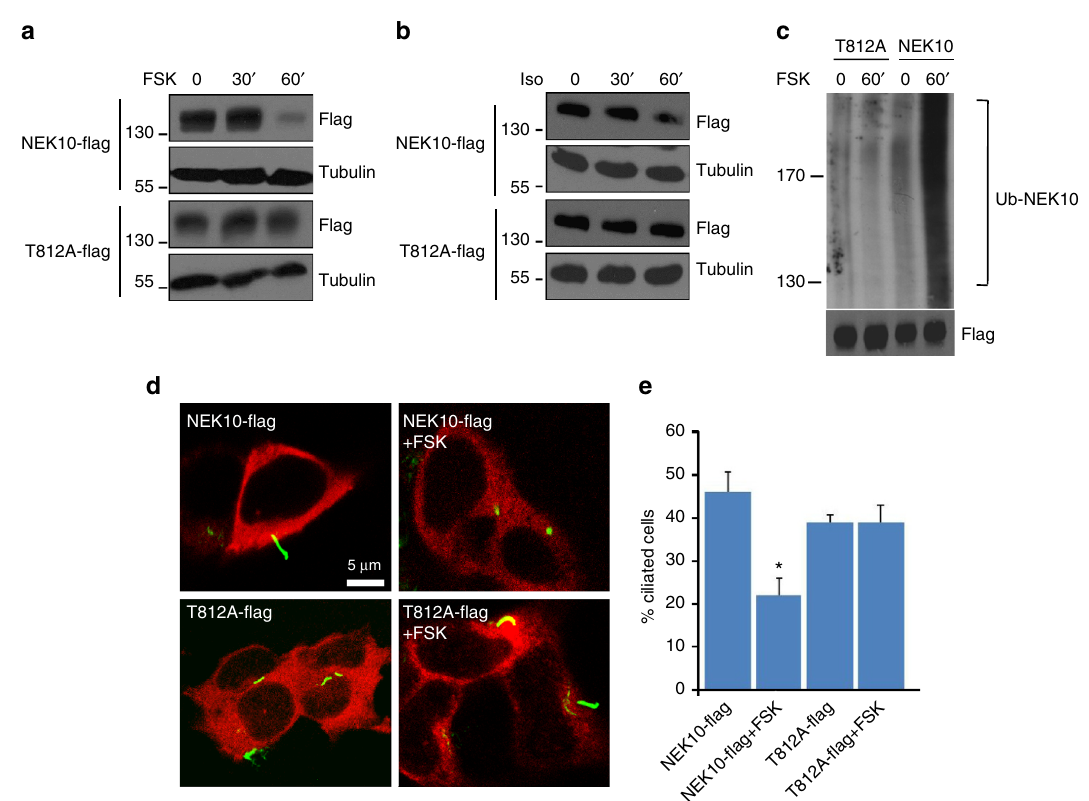
Fig. 4 PKA phosphorylation induces NEK10 proteolysis and cilia resorption. a – b Cells transfected with either wild-type NEK10- fl ag or with T812A- fl ag mutant were left untreated or stimulated with forskolin ( a ) or isoproterenol ( b ) for 30 – 60 min. Lysates were immunoblotted for fl ag and tubulin. c Cells were transiently co-transfected with NEK10- fl ag construct (either wild type or T812A mutant) and HA-ubiquitin. 24 h after transfection, cells were treated with MG132 (20 µ M) for 1 h and then stimulated with FSK. Lysates were subjected to immunoprecipitation with anti- fl ag and immunoblotted with anti-HA and anti- fl ag. d Cells transfected with either wild-type NEK10- fl ag or with T812A- fl ag mutant were serum deprived for 36 h, left untreated or stimulated with FSK (3 h) and doubly immunostained for acetylated tubulin and fl ag. e Quantitative analysis of fl ag-positive ciliated cells expressing either wild type or T812A NEK10 mutant. Cumulative data from three independent experiments are shown. For each group a minimum of 100 cells/experiment was averaged. * p < 0.05 versus NEK10- fl ag and T812A